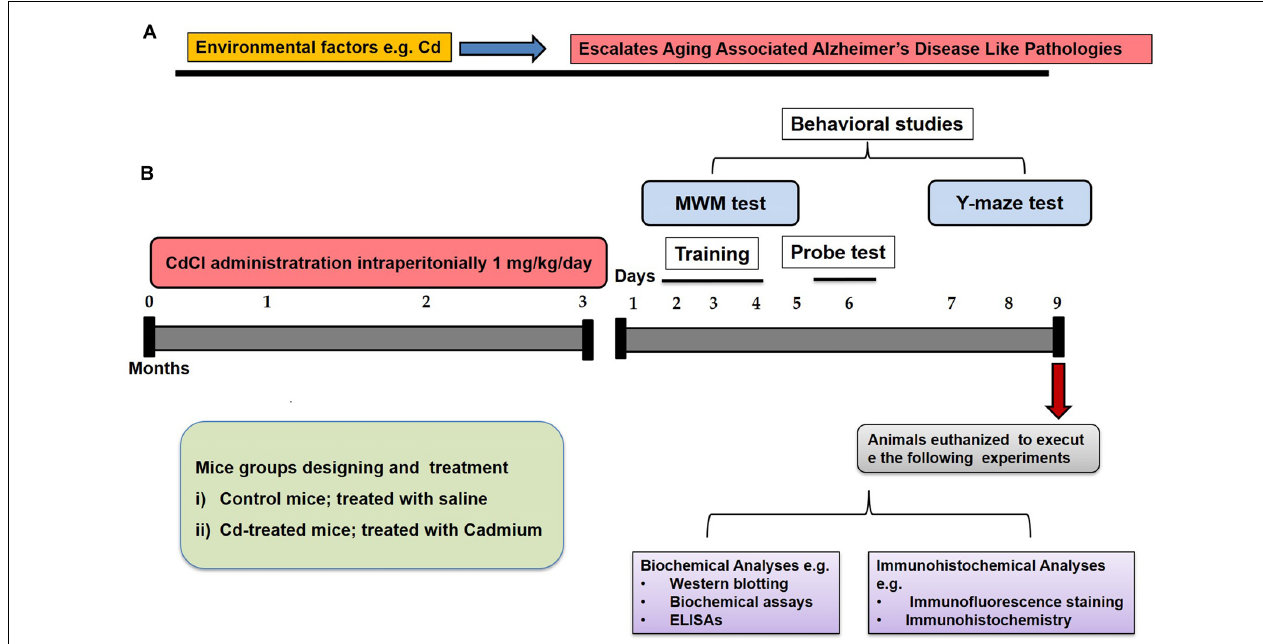
FIGURE 1 | Schematic diagram. (A) These schematic illustrations show our hypothesis for interaction and synergistic effects of an environmental factor (Cd) and aging. (B) The illustrative graphical representation indicated our study designing to establish the control of aging and Cd-induced aging models. The treatment paradigms, behavioral studies [Morris water maze (MWM) and Y-maze tests], animal authorization, and biochemical as well as immunohistochemical representation were indicated for the entire study.